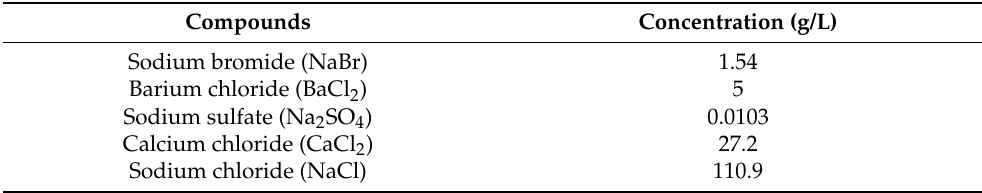
Table 1. Composition of synthetic SGPW.